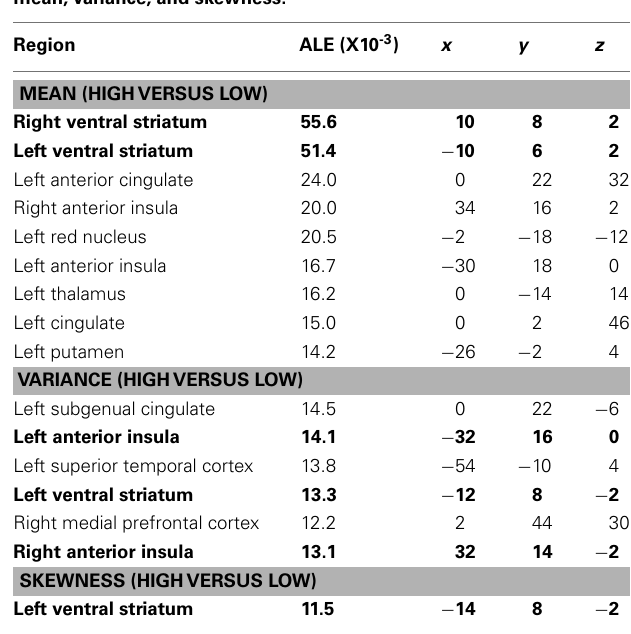
Table 2 |ALE of neural foci implicated in processing high versus low mean, variance, and